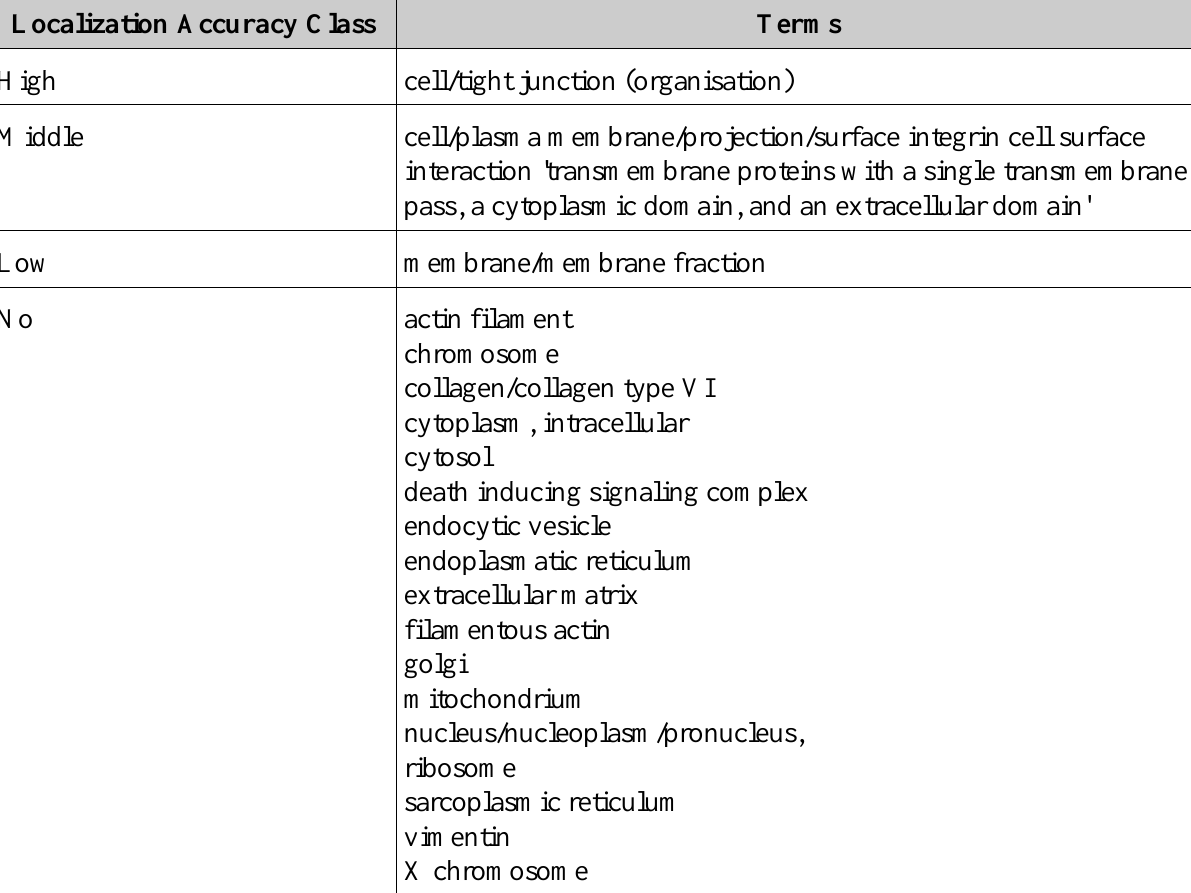
Table 2: Localization Accuracy Classes of the terms found by CmPI and ANDVisio in comparison to the reference term “cell